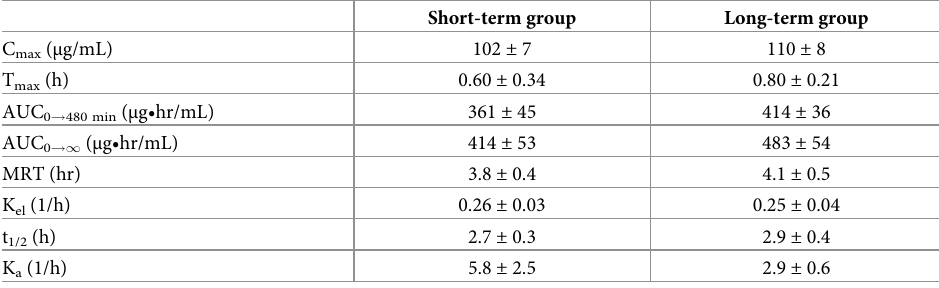
Table 2. Pharmacokinetic parameters of concurrent administration of LEV and RASS.